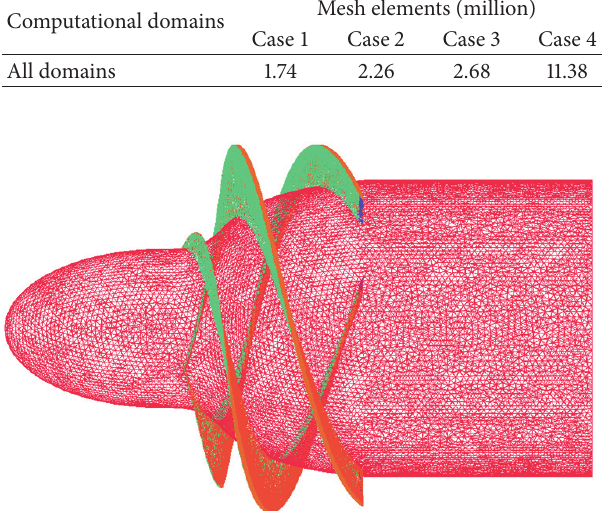
Table 1: The parameters of blade high-performance computing clusters system.